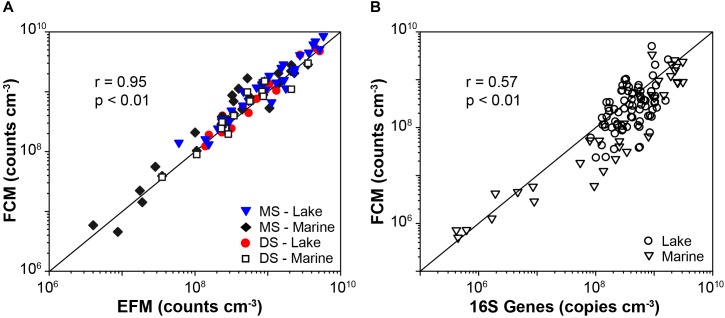
(A) Comparisons of cell abundances determined by EFM and FCM enumerations, which involved results based on both membrane staining (MS) and direct staining (DS), in lake and marine samples (46 samples). Solid lines indicate 1:1 lines. (B) Compare 16S gene rRNA abundances determined by qPCR to FCM counts of lake and marine sediment based on the membrane staining technique (n = 110).